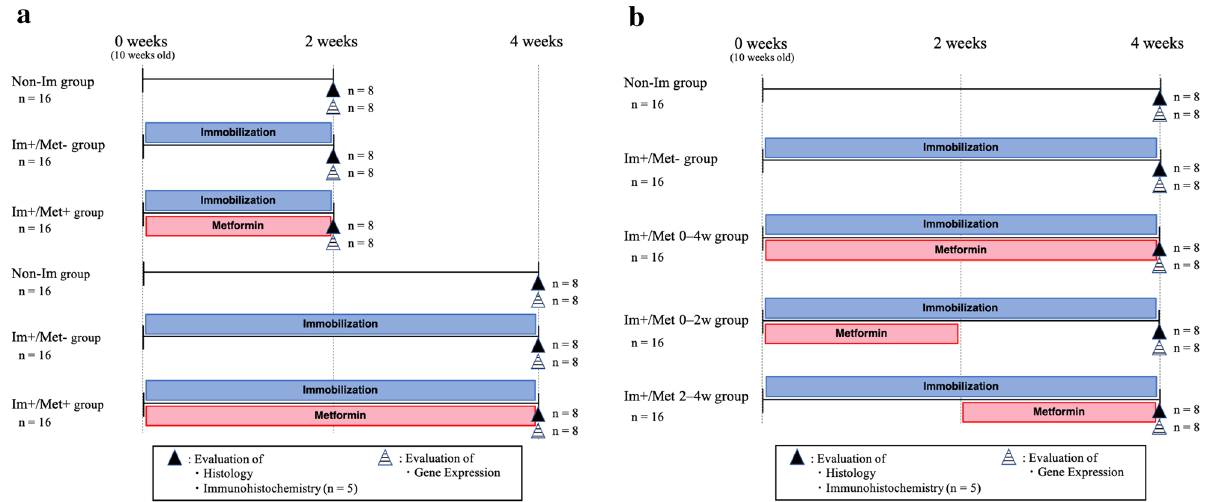
Figure 1. Study flow chart. The flow chart shows the experimental design and number of mice used per experiment/outcome in this study for determining ( a ) the effect of metformin for joint contracture, and ( b ) the effective time of metformin administration for joint capsular fibrosis. Non-striped upward triangles indicate the histological and immunohistochemical analyses. Striped upward triangles indicate gene expression analysis. Non-Im, mice with non-immobilized knees; Im+/Met−, mice with immobilized knees but no metformin; Im+/Met+, mice with immobilized knees who were administered metformin; Im+/Met 0–4 weeks, mice with immobilized knees and metformin administered from 0 to 4 weeks; Im+/Met 0–2 weeks, mice with immobilized knees and metformin administered from 0 to 2 weeks; Im+/Met 2–4 weeks, mice with immobilized knees and metformin administered from 2 to 4